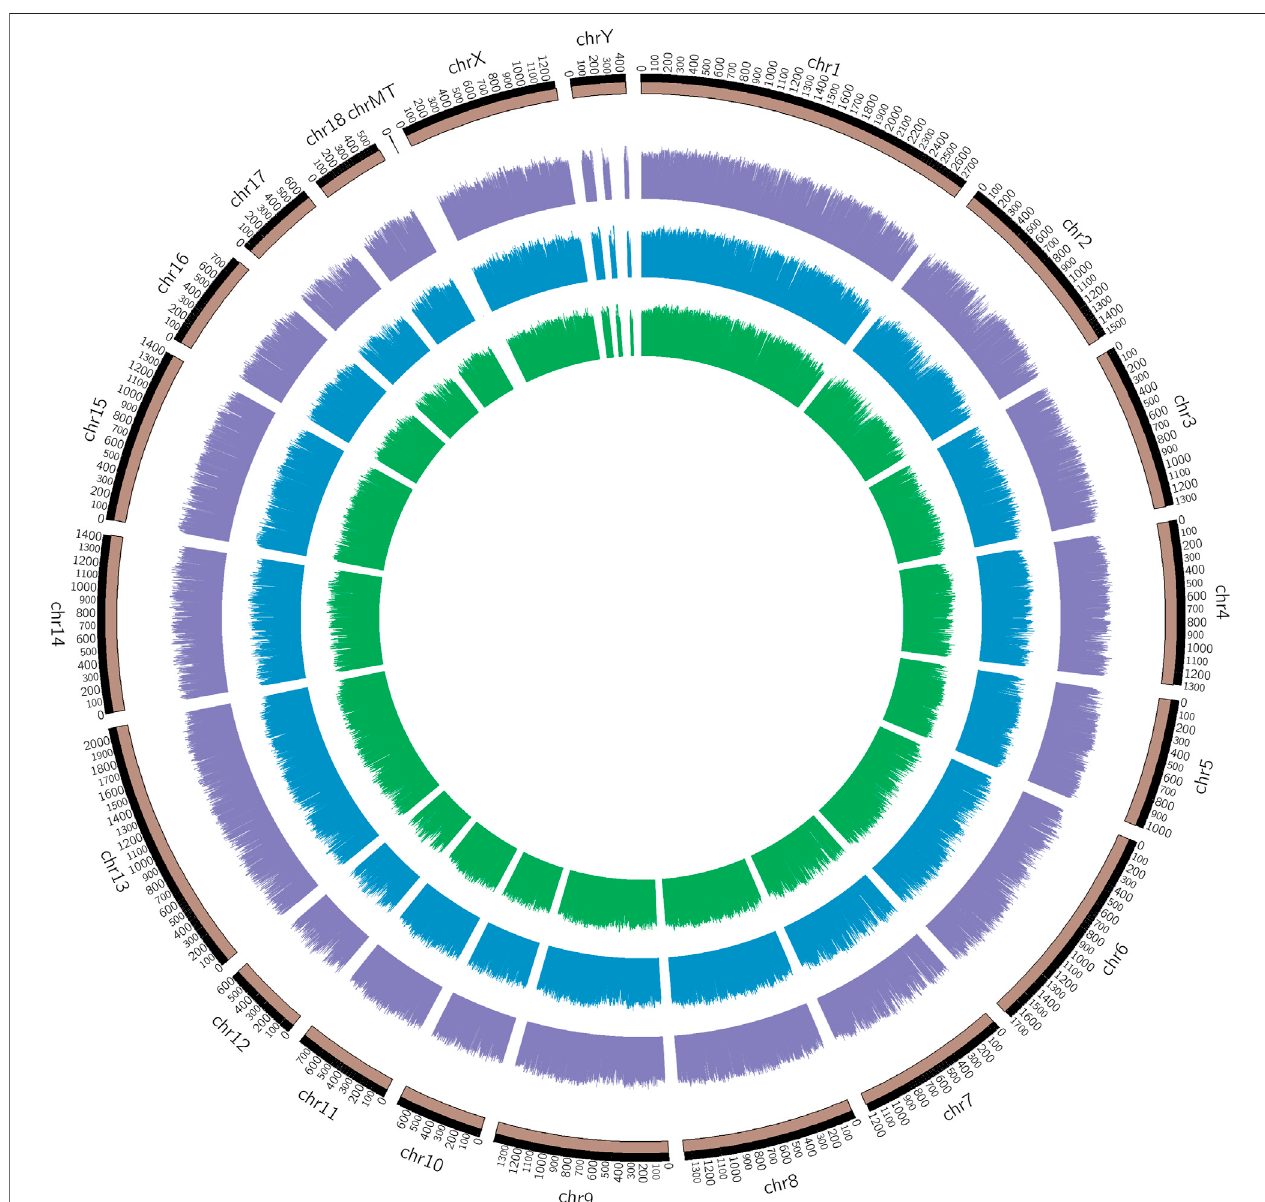
FIGURE 2 | Genomic distribution of DMRs among Cp infected and uninfected piglets. Note: From the inner circle to the outer circle represents the IR vs. IC, IS vs. IC, and IS vs. IR groups.